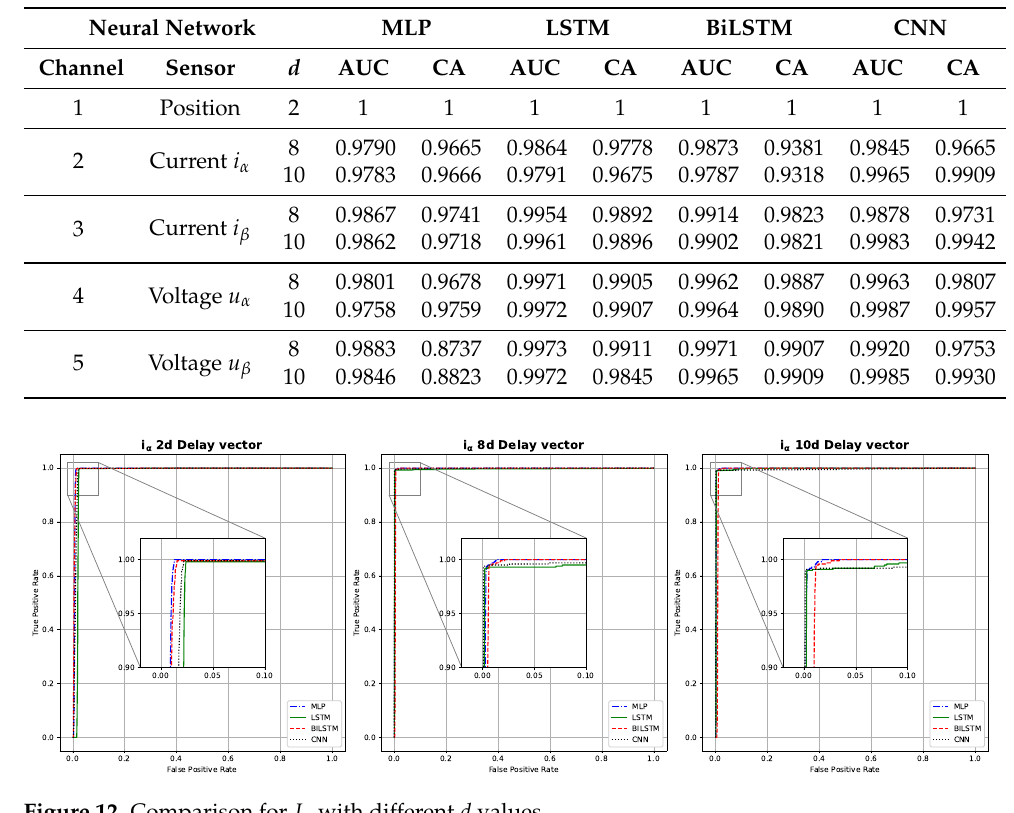
Figure 12. Comparison for I α with different d values.